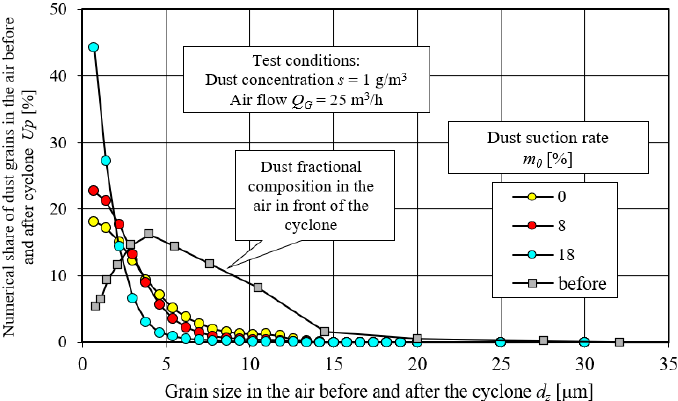
Figure 13. The impact of the suction rate m 0 on the numerical share U p of the dust grains in the outlet air from the pass-through cyclone